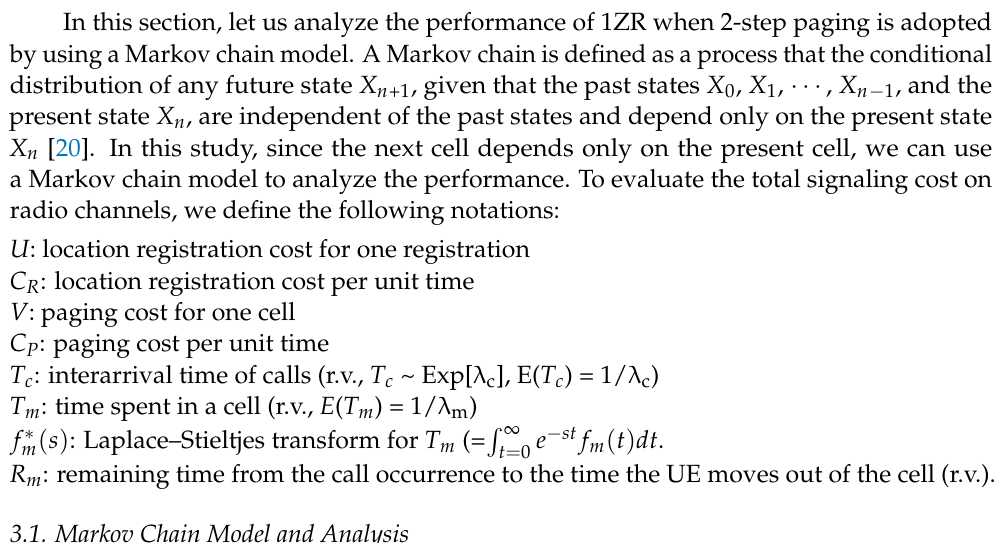
Figure 6. Inter-cell mobility model in a zone in 1ZR when a UE moves from the zone in the left ( n = 9).